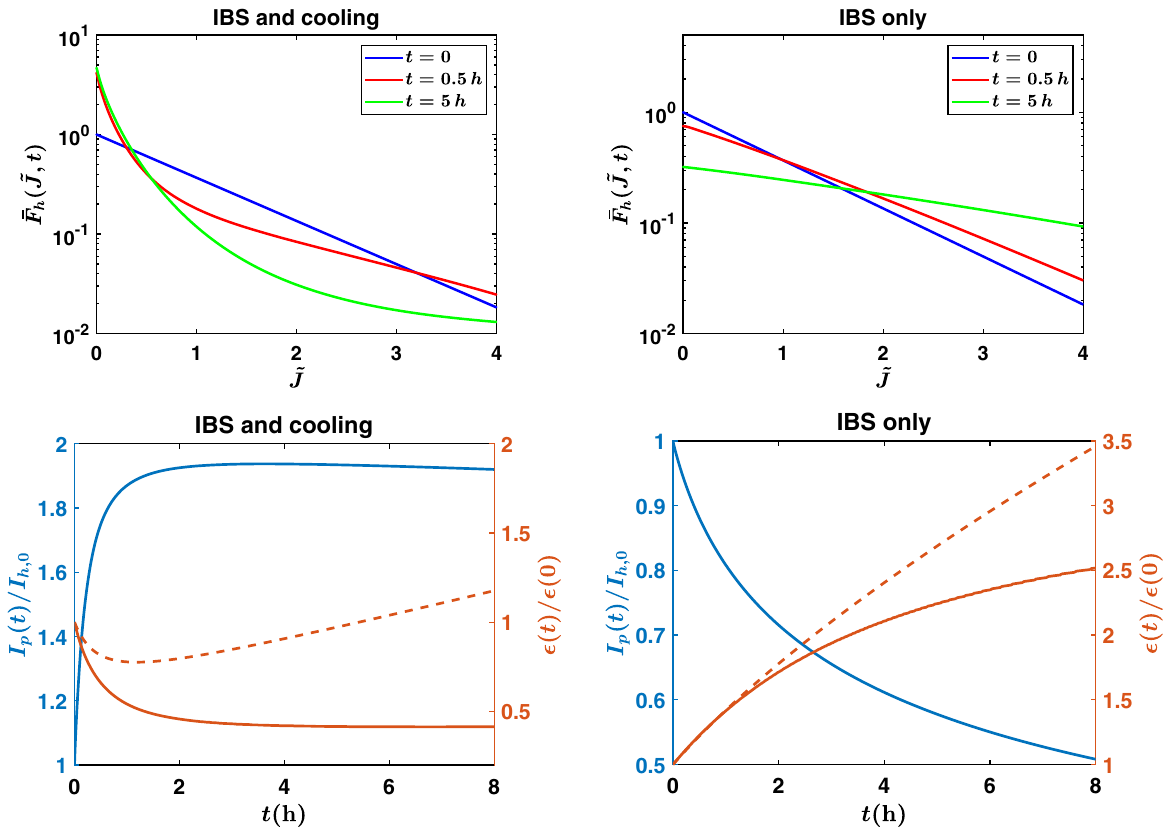
FIG. 6. Upper panel: hadron distribution function at selected times during the cooling process. Lower panel: hadron peak current (blue curve), total longitudinal emittance (dashed brown curve) and core part (95%) emittance (solid brown curve) versus time. The data shown compare and contrast the cases with and without